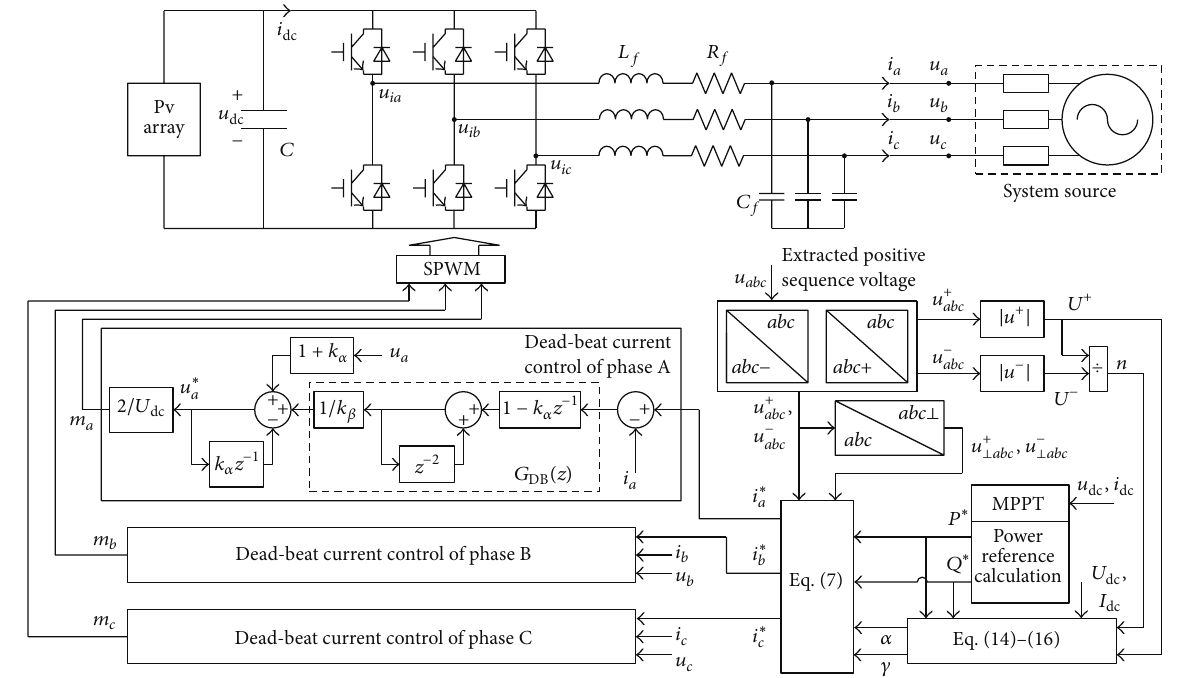
Figure 7: Block diagram for improved power control of photovoltaic